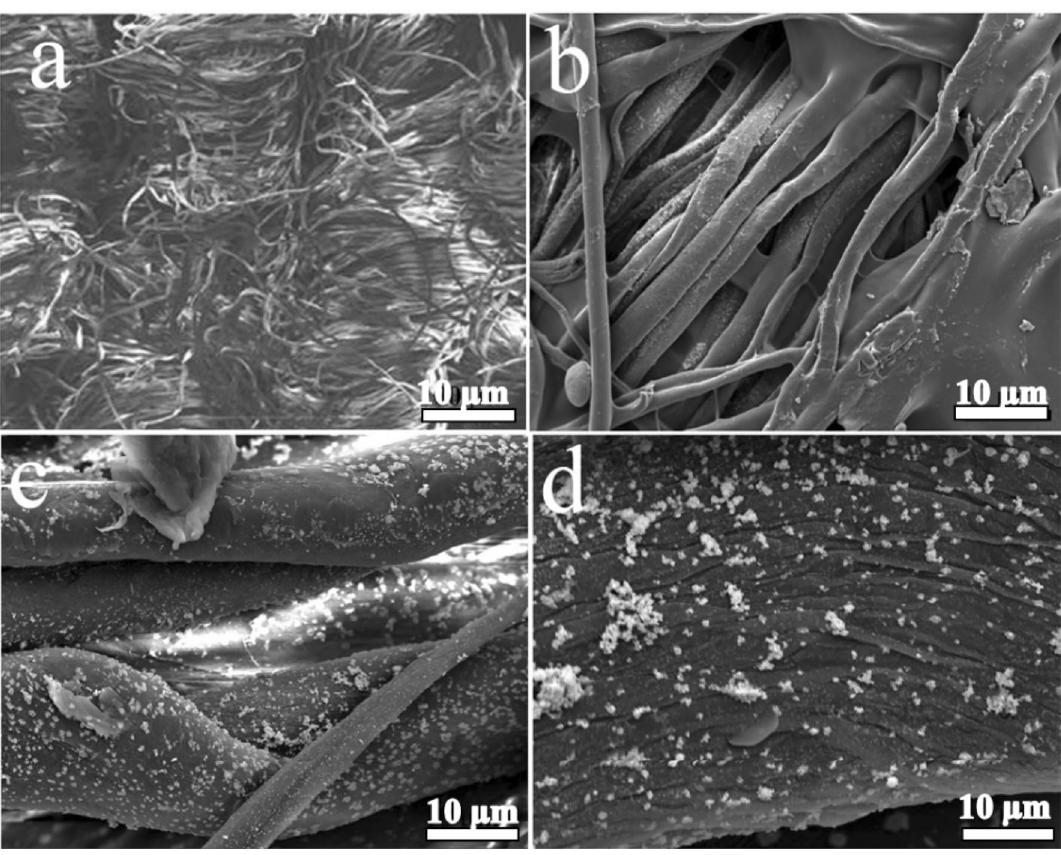
Figure 3. SEM images of non-woven cotton fabric (NWCF) ( a ), AgNPs-NWCF ( b ), Chitosan@AgNPs-NWCF ( c ), and N-halamine-chitosan@AgNPs-NWCF ( d